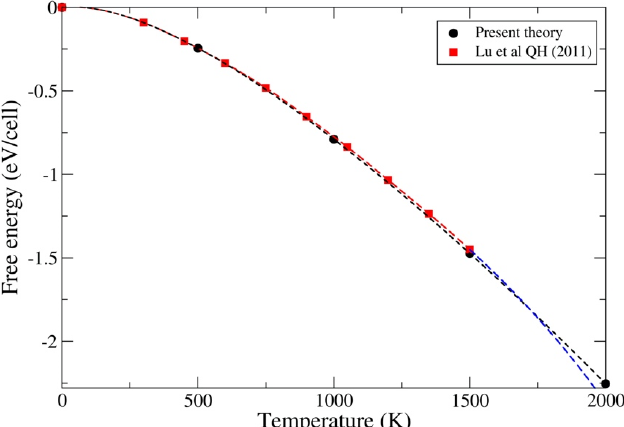
Figure 3. Free energy for ThN from present theory together with results from a first-principles quasi- harmonic (QH) model [11] where the blue dashed curve (above 1500 K) is a cubic-spline extrapolation. Results are shown as solid symbols and dashed lines are guides for the eye only.